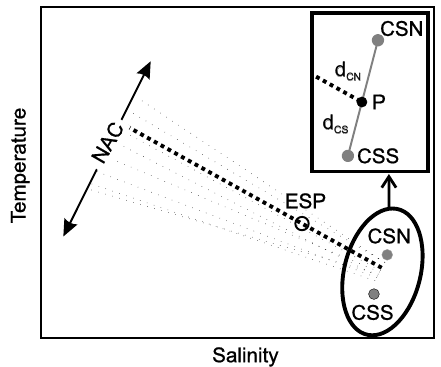
Figure A1. Sketch of the mixing between two Mediterranean wa- ters of characteristics CSN and CSS (large filled dots) and the North Atlantic Central Water (NACW) (double-headed arrow) based on Fig. 4a (dimensions exaggerated). Several possible mixing lines with different fractions α CSN , α CSS , and α NAC have been sketched. The particular case of mixed water with characteristics ESP (empty dot), whose position in the T − S diagram depends on the fractions intervening in the mixing, is discussed in the text. This empty dot can be seen as the result of a mixing between CSN and CSS to give point P (see inset), followed by a subsequent mixing between P and the